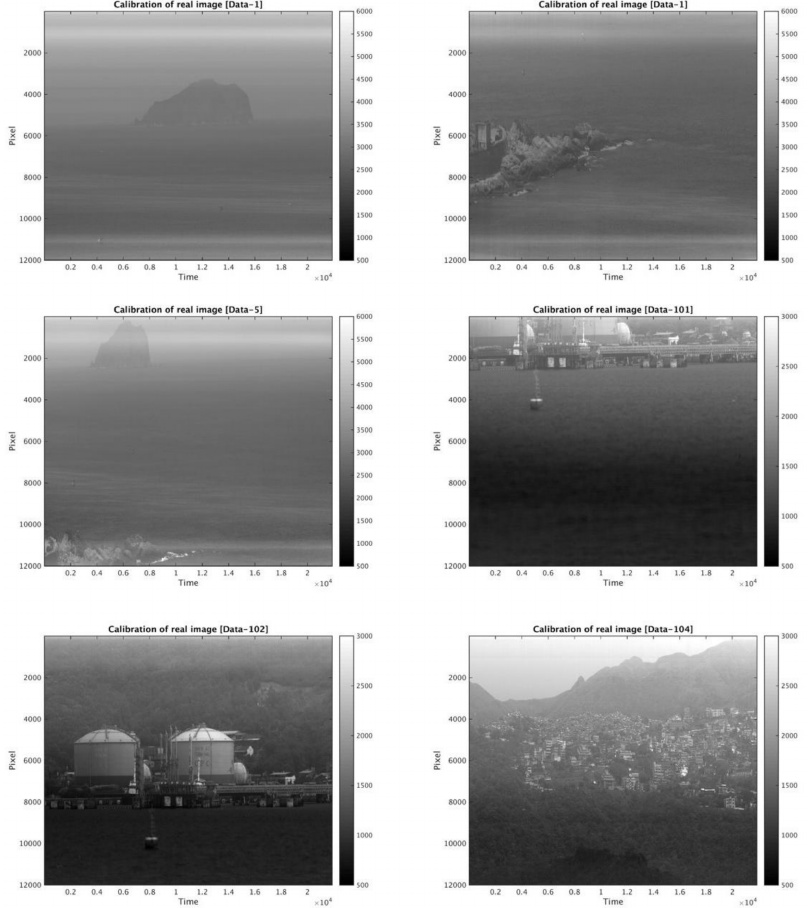
Figure 14. Same as Figure 4, but after EMD–HHT relative radiometric